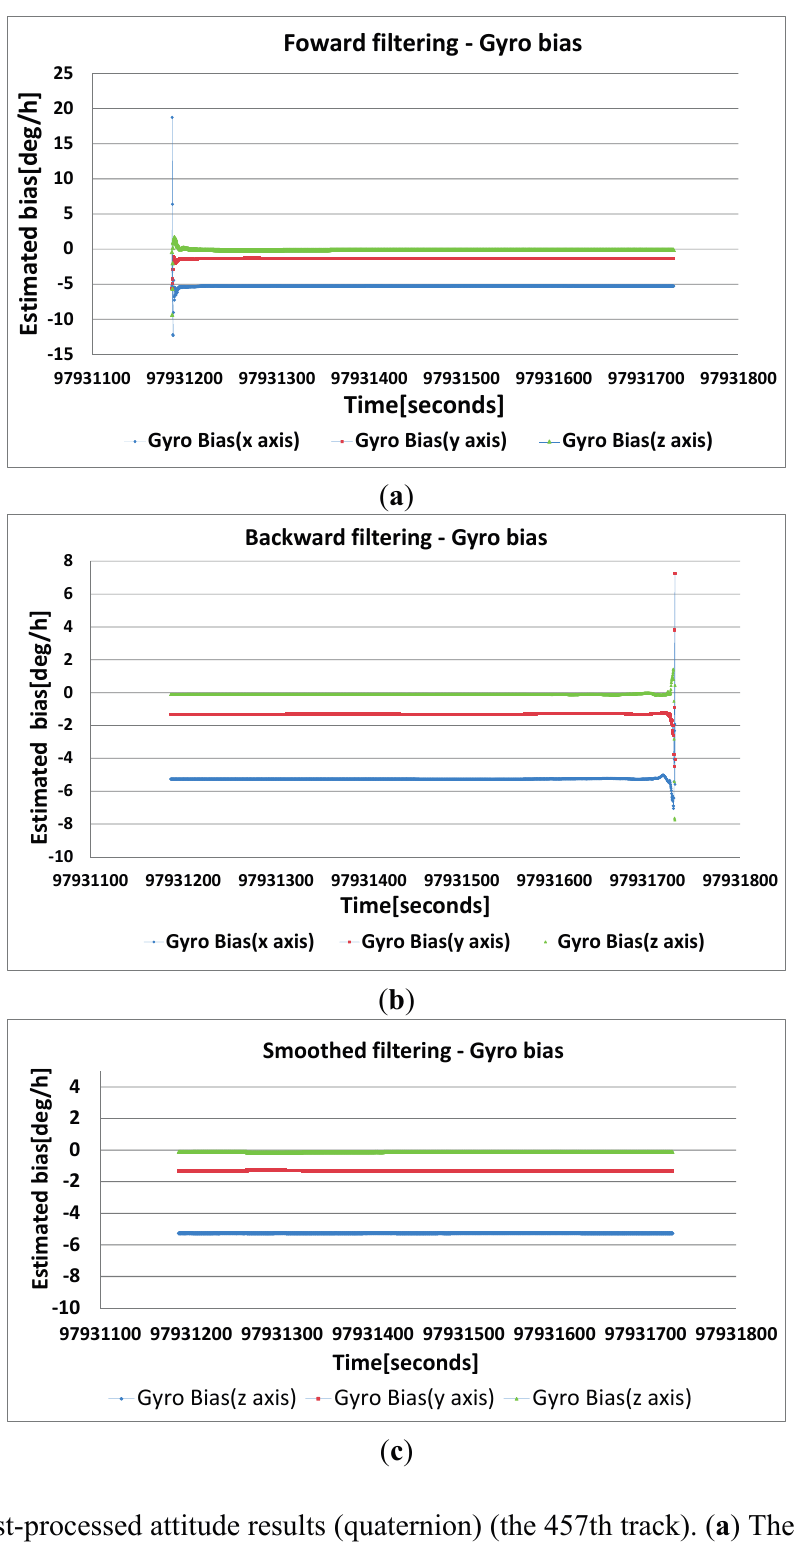
Figure 7. Post-processed attitude results (quaternion) (the 457th track). ( a ) The gyro bias of the forward filtering; ( b ) the gyro bias of backward filtering; ( c ) The gyro bias of the smoothed